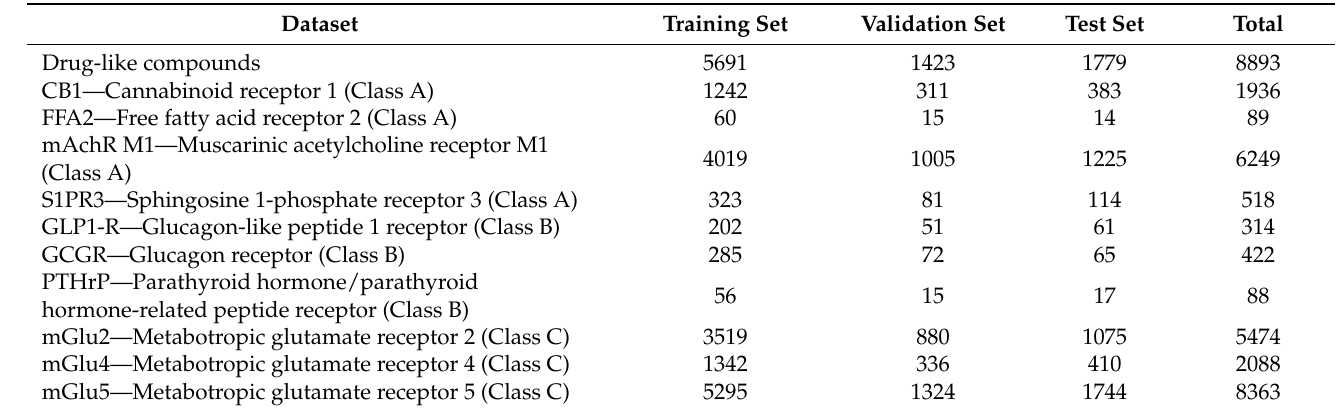
Table 1. Dataset